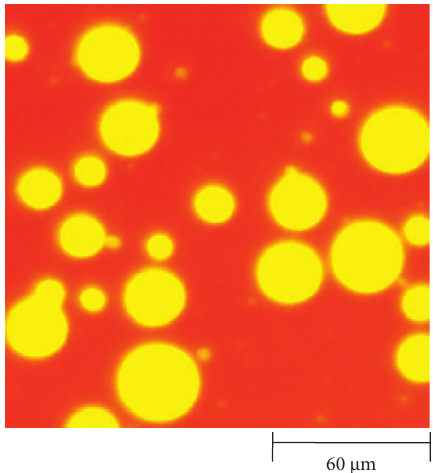
Figure 5: Fluorescence micrographs of undeveloped SBS modified asphalt with 10% content of APR.